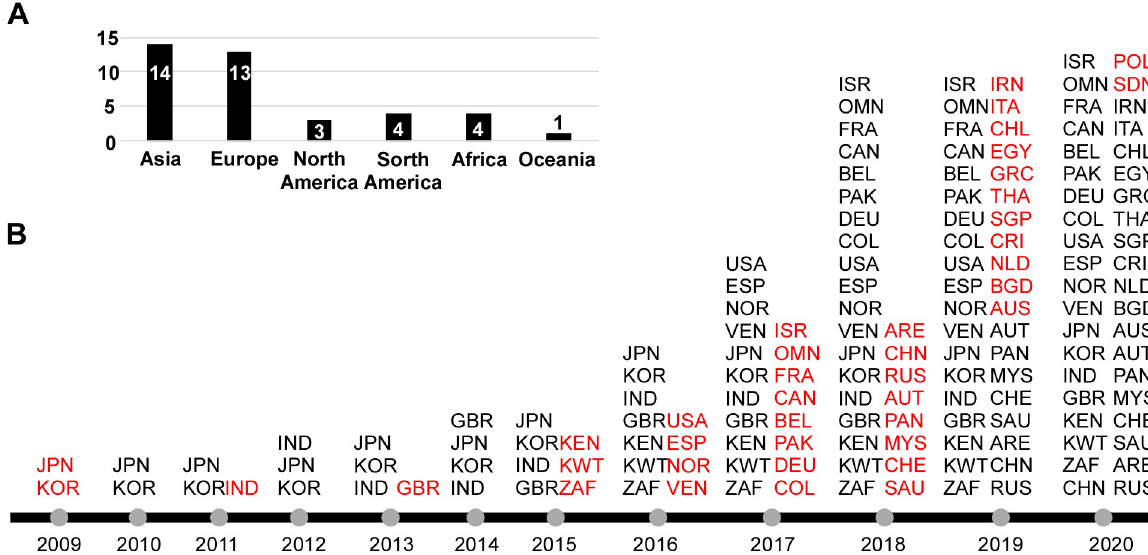
Fig 2. Countries with reported cases of C . auris infection or colonization from January 2009 to June 2020. (A) Number of countries belonging to each continent that have reported infection or colonization with C . auris . (B) Countries with reported cases from January 2009 to June 2020. The first reported case from each country is denoted in red text. ARE, United Arab Emirates; AUS, Australia; AUT, Austria; BEL, Belgium; BGD, Bangladesh; CAN, Canada; CHE, Switzerland; CHL, Chile; CHN, China; COL, Colombia; CRI, Costa Rica; DEU, Germany; EGY, Egypt; ESP, Spain; FRA, France; GBR, United Kingdom; GRC, Greece; IND, India; IRN, Iran; ISR, Israel; ITA, Italy; JPN, Japan; KEN, Kenya; KOR, Korea (South); KWT, Kuwait; MYS, Malaysia; NLD, the Netherlands; NOR, Norway; OMN, Oman; PAK, Pakistan; PAN, Panama; POL, Poland; RUS, Russia; SAU, Saudi Arabia; SDN, Sudan; SGP, Singapore; THA, Thailand; USA, United States of America; VEN, Venezuela; ZAF, South Africa.